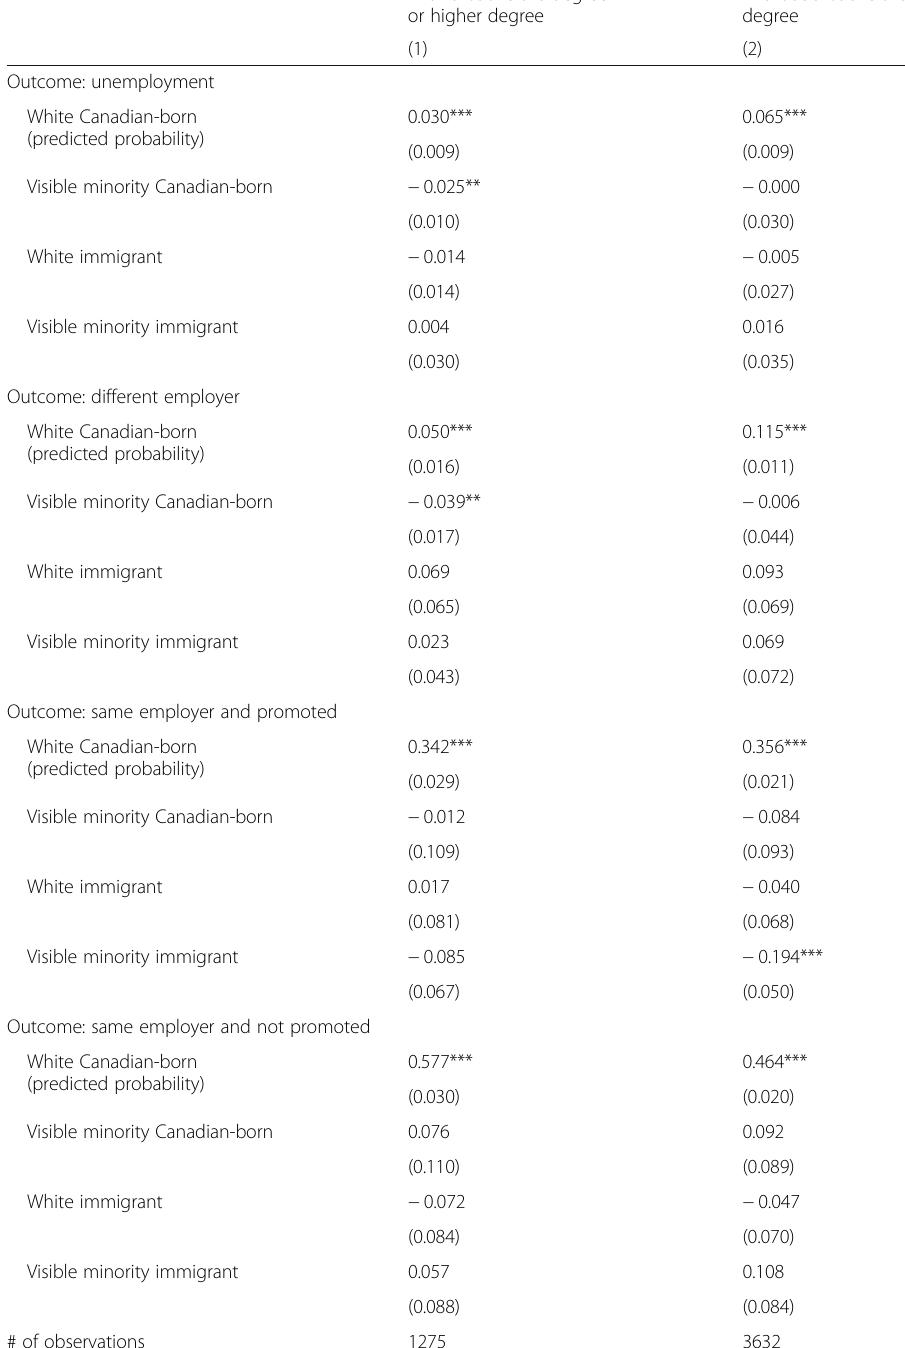
With a bachelor ’ s degree or higher degree